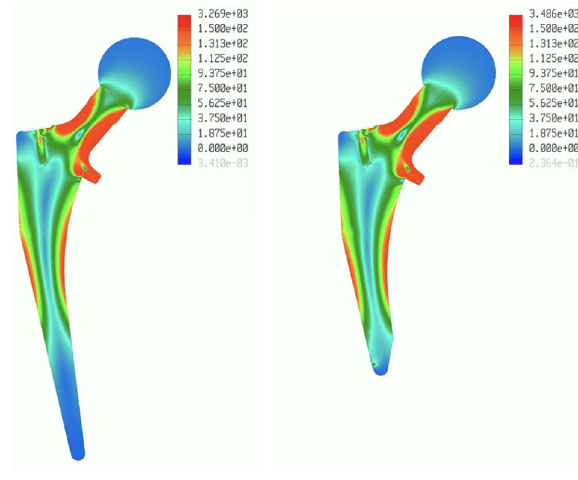
Figure 4. Diagrams representing the Von Mises stress repartition for a standard collared stem and a shortened collared